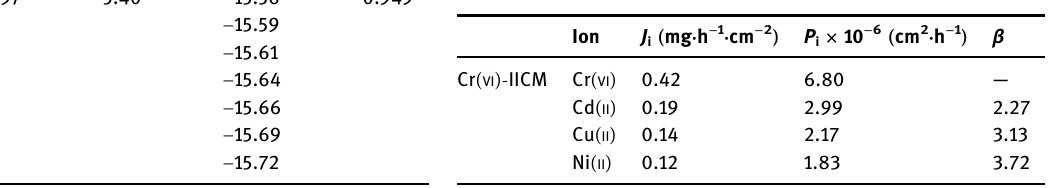
Table 7: Permeability parameters of Cr ( VI )- IICM to